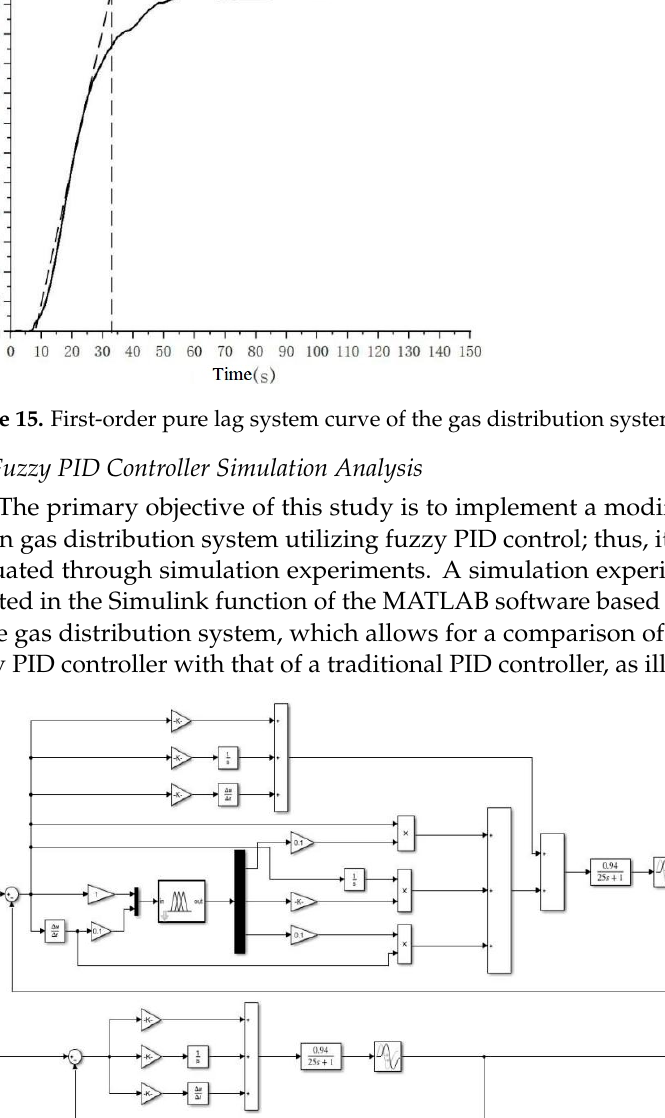
Figure 17. System simulation results. As illustrated by each graph, the traditional PID controller (represented by the blue curve) initially exceeds the setpoint and gradually returns to it, while the peak of the fuzzy PID controller (represented by the red curve) aligns with the setpoint. This demonstrates that the fuzzy PID controller is capable of achieving minimal overshoot during gas distribution. In general, the fuzzy PID controller demonstrates superiority over the traditional PID controller in terms of increasing the speed of gas distribution, enhancing the accuracy of gas distribution, reducing overshoot during gas distribution, and adapting to the different parameters of the gas distribution system.